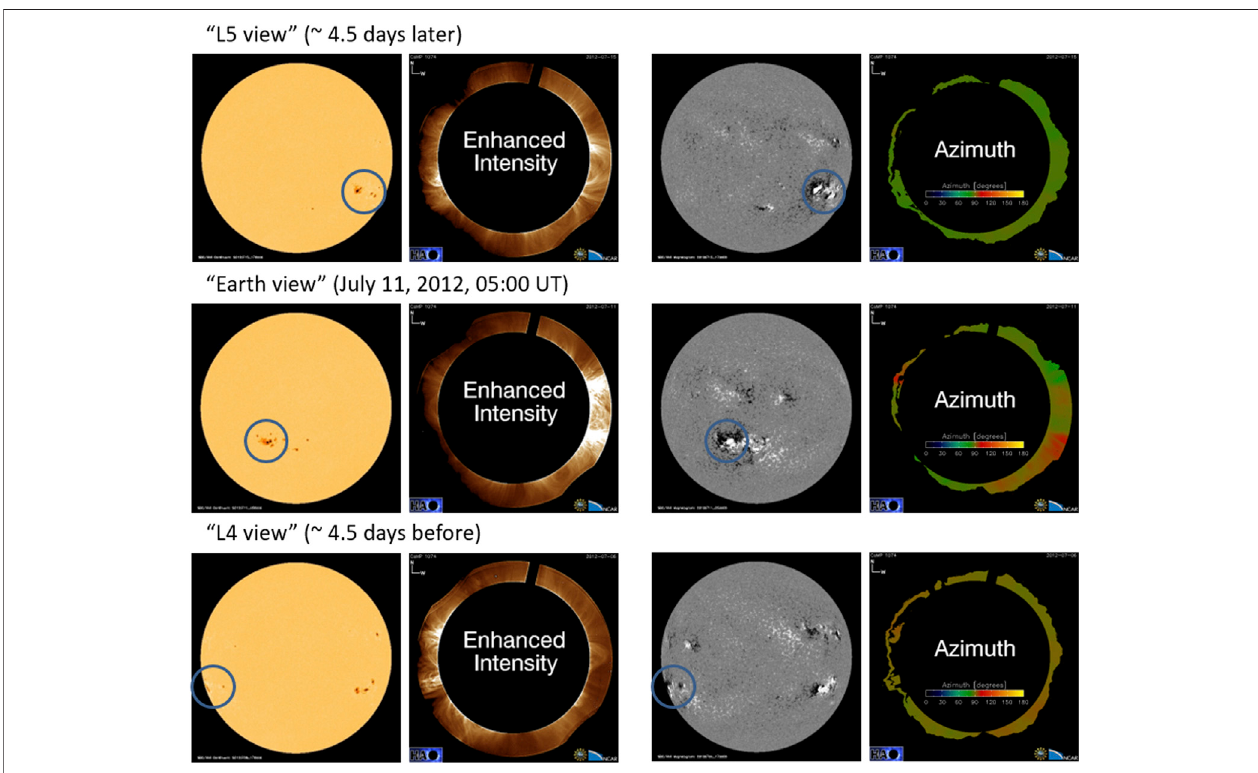
FIGURE 1 | Example of a possible combination of data acquired from L5 (top row) , L1 (middle row) , and L4 (bottom row) vantage point. The different columns showthevisiblephotosphere (leftcolumn) ,theinnercorona (middleleftcolumn) ,andthecorrespondingphotospheric fi elds (middlerightcolumn) andcoronal fi eld azimuth (right column) . The location of the same sunspot group is outlines with a